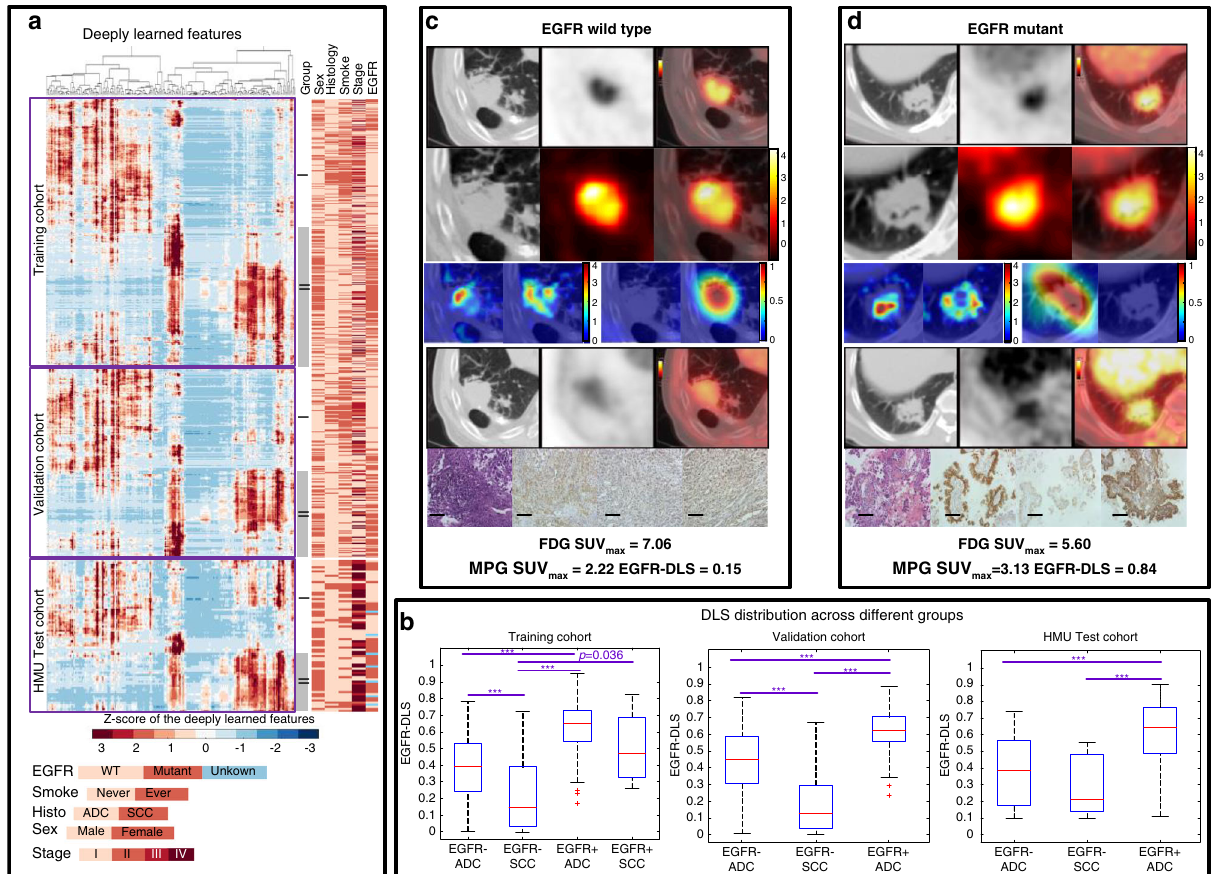
Fig. 3 The unsupervised clustering of the deep learning features, the distribution of the EGFR-DLS, and two NSCLC adenocarcinoma patients with different EGFR mutation status. a The unsupervised hierarchical clustering of the deep learning features (i.e., the output of global average pooling, N = 256) on the vertical axis, which shows a signi fi cant association of the deep learning expression patterns with EGFR mutation (training: p < 0.001, validation: p < 0.001, HMU: p = 0.002, χ 2 test). There was also signi fi cant association of the expression patterns by stage (training: p < 0.001, validation: p < 0.001,